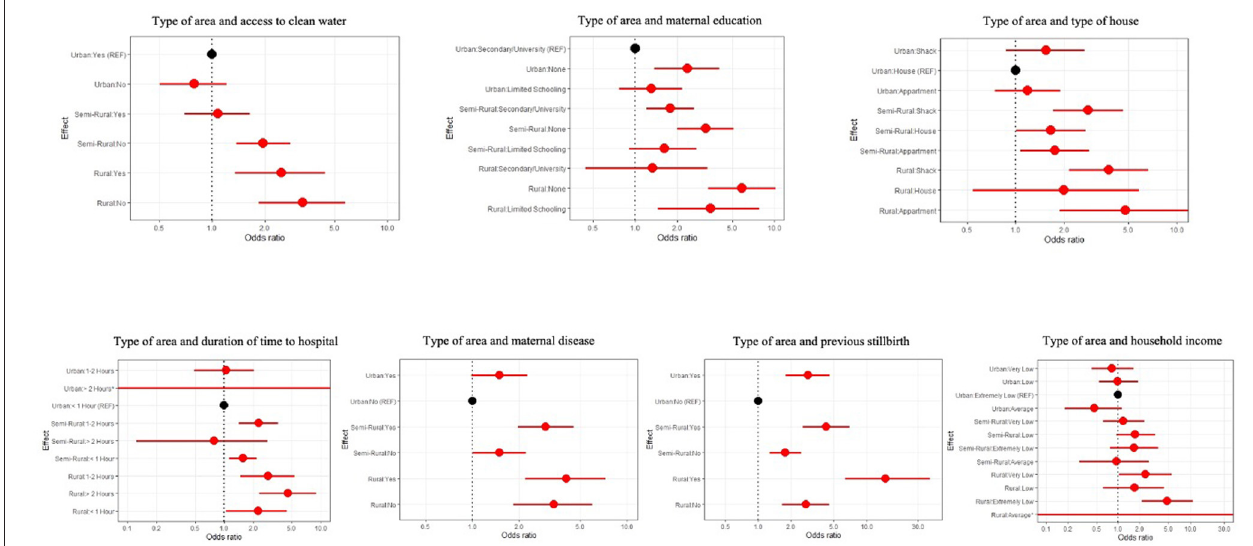
FIGURE 4 | Forest plots for area type and the following confounding variables: access to clean water, maternal education, type of house, time traveled to the hospital, maternal disease, previous stillbirth(s), and household